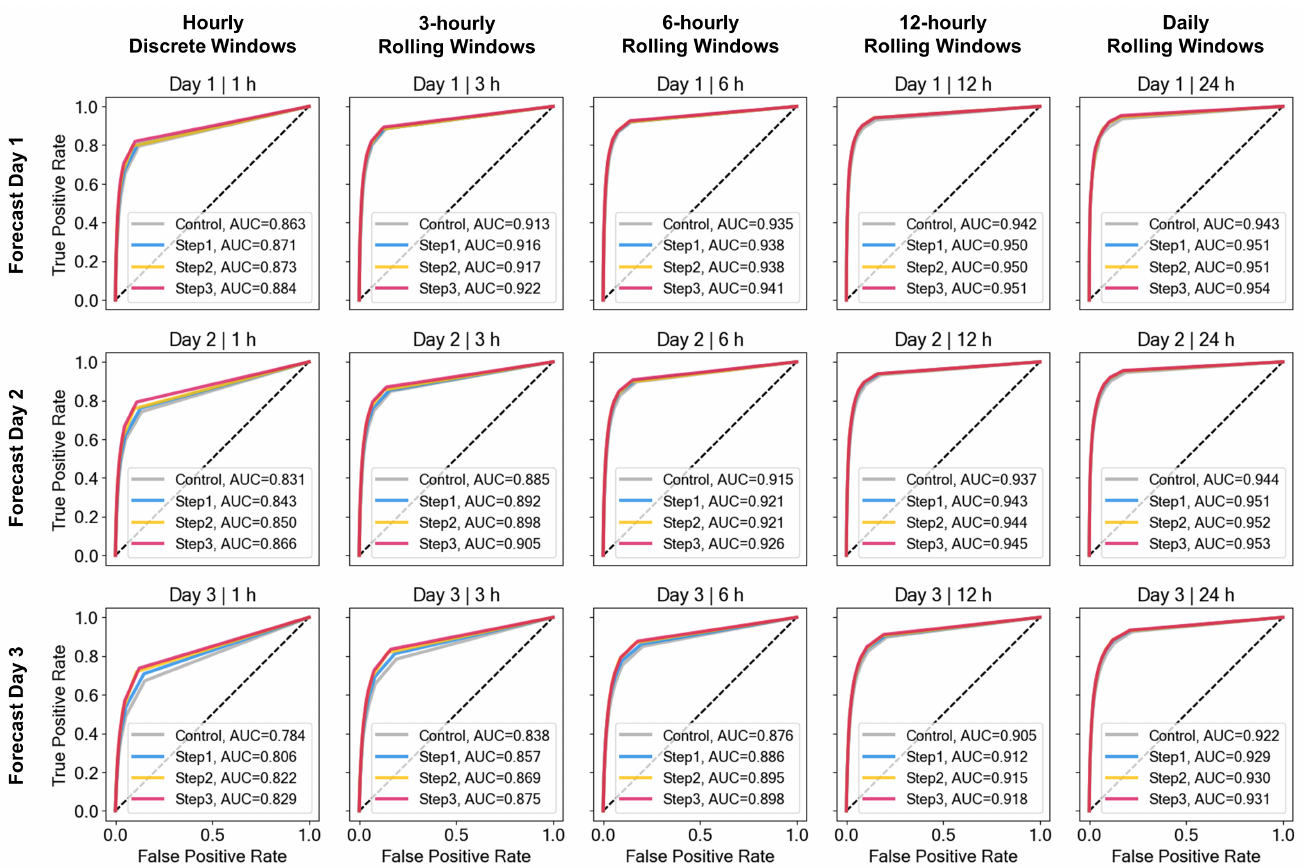
Figure 10. Station-aggregated 90p receiver operating characteristic (ROC) diagrams for all forecast days and hourly discrete to daily rolling accumulation windows. The area under the curve (AUC) is given in each legend and has a perfect score of 1. The dashed black line represents the line of no skill with AUC = 0.5 corresponding to